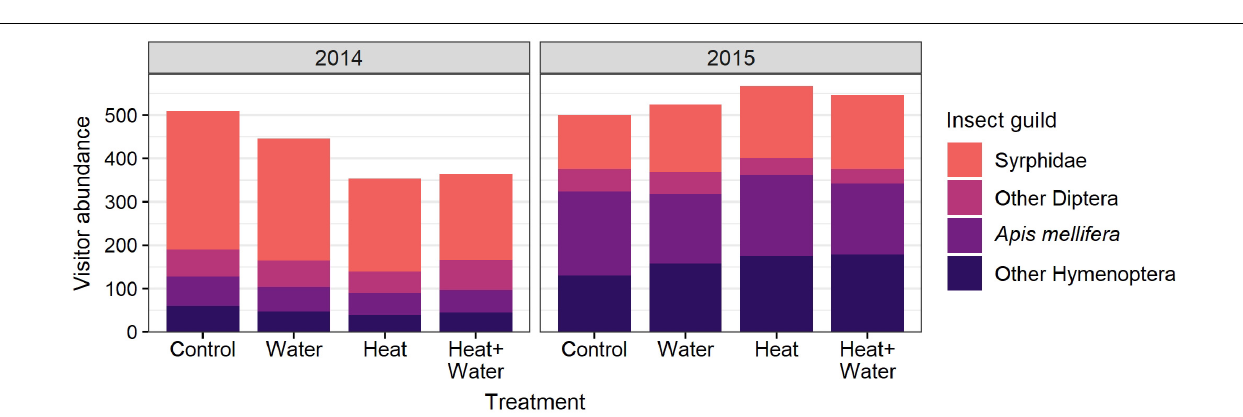
Frontiers in Plant Science |